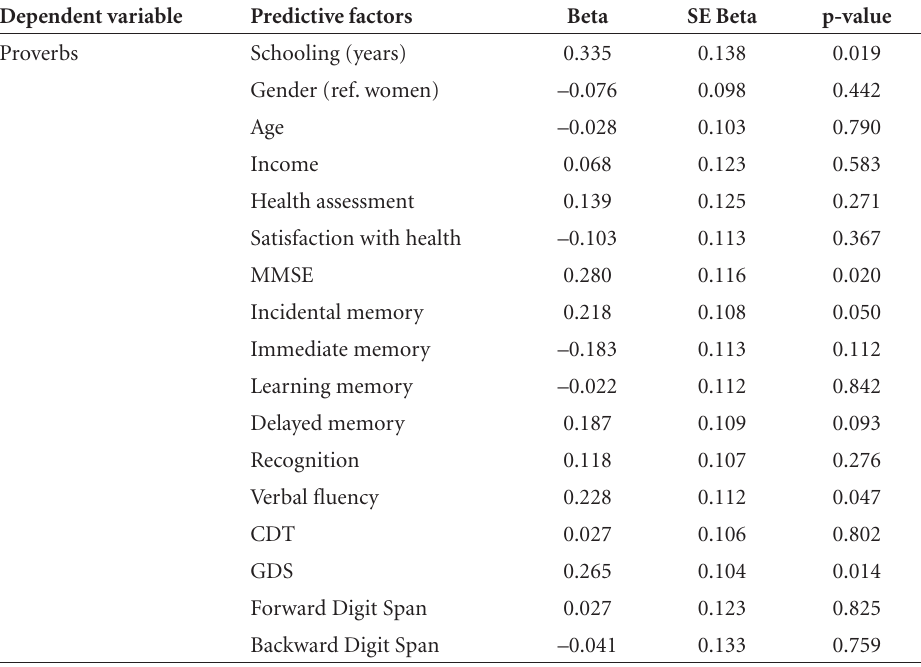
Table 4. Univariate regression analysis for Proverb Test scores including sociodemographic and cogni- tive variables.